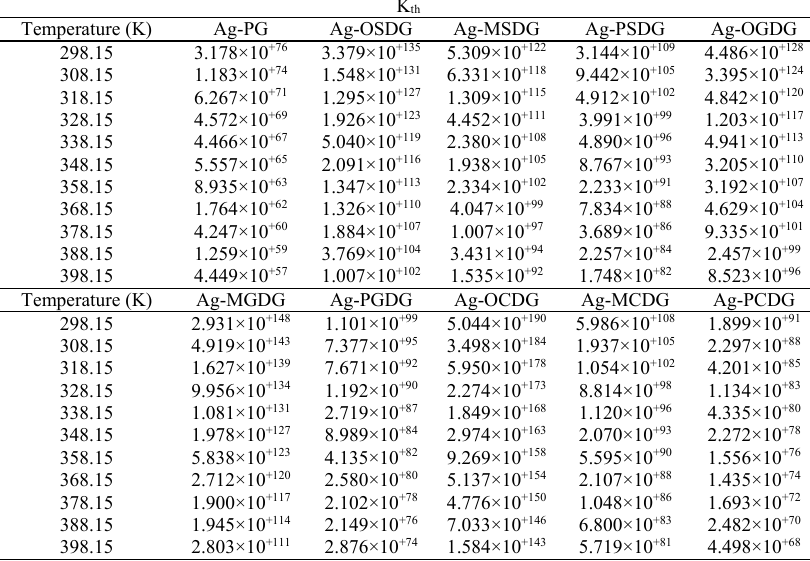
Table 4. Thermodynamic equilibrium constants for the adsorption of silver (I) on the surface of ordinary and doped graphenes in the temperature range of 300-400 K. K th Temperature (K)